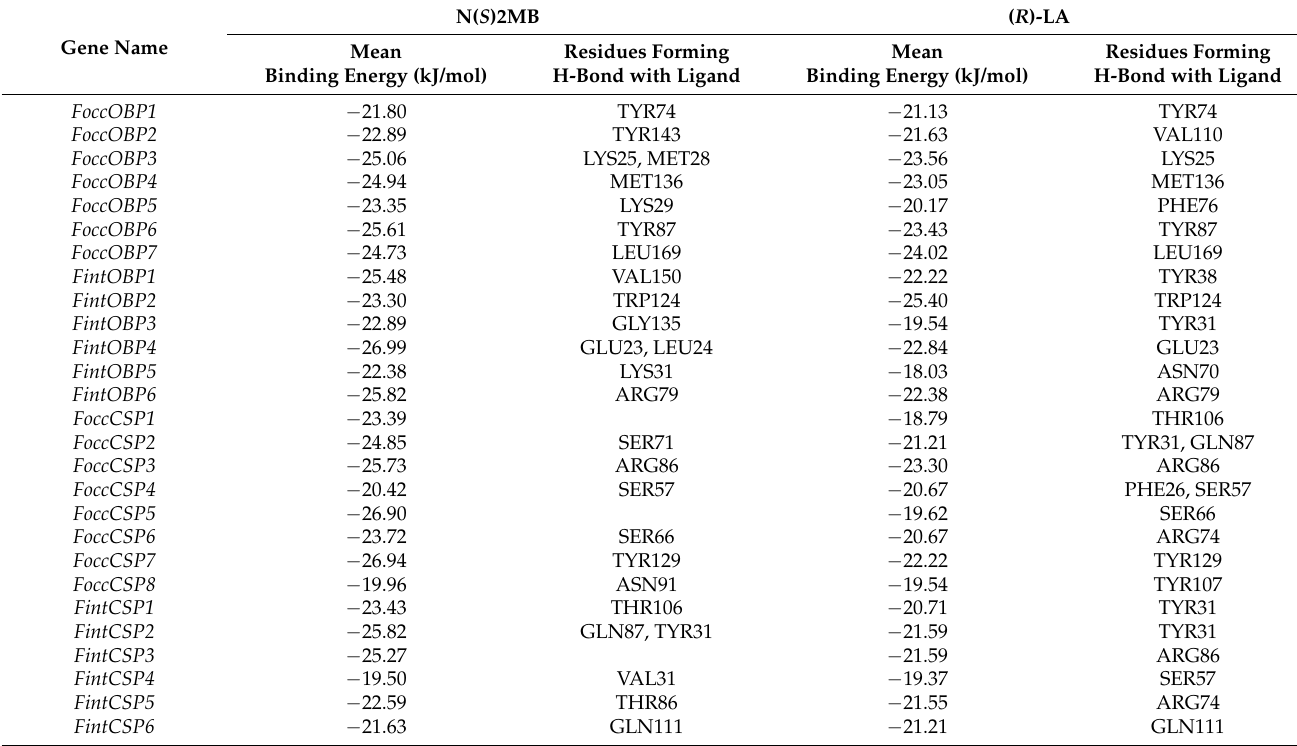
Table 3. Docking score and molecular docking results of OBPs and CSPs with aggregation pheromone compounds of Frankliniella occidentalis and Frankliniella intonsa